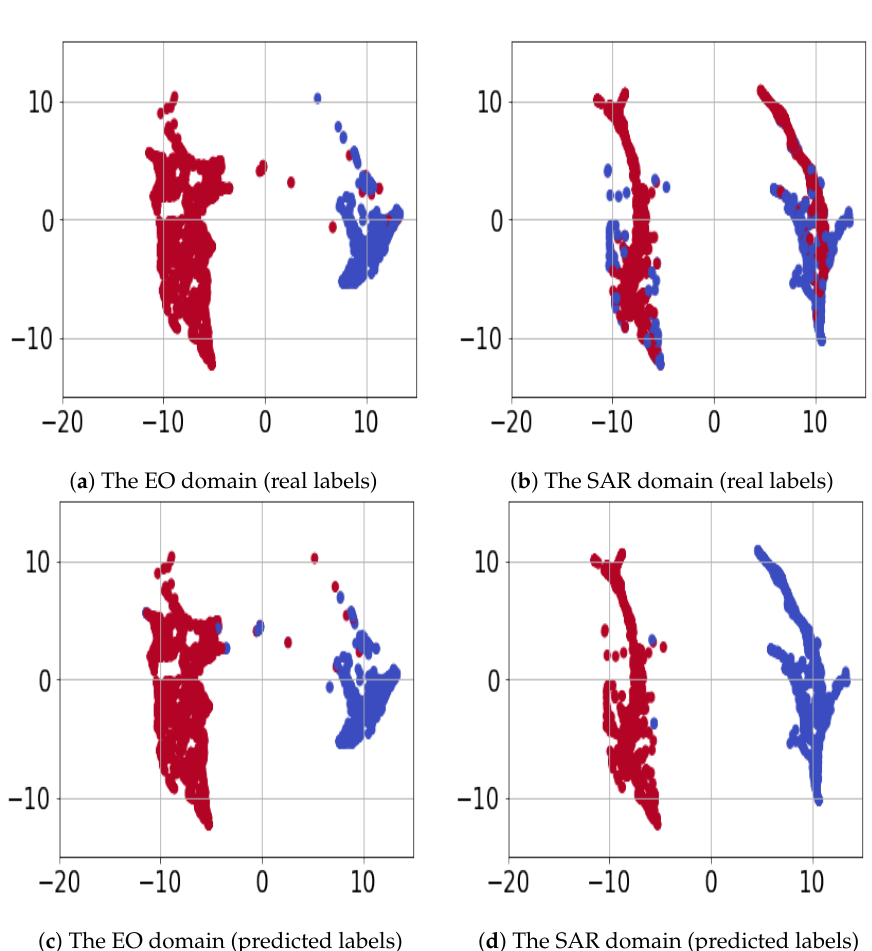
Figure 5. Umap visualization of the EO versus the SAR dataset for the ablation study (view in